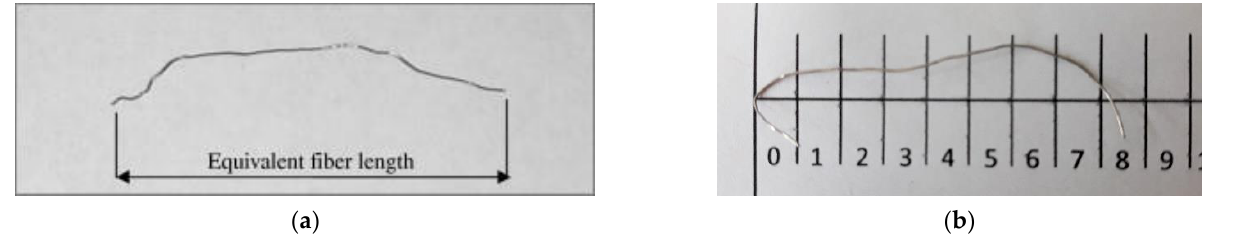
Figure 4. Examples of RSF length characterization: ( a ) from [32]; ( b ) used in this paper.